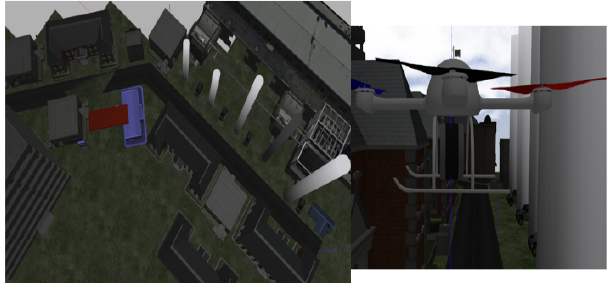
Figure 3. The Microdrones md4-1000 drone simulated in